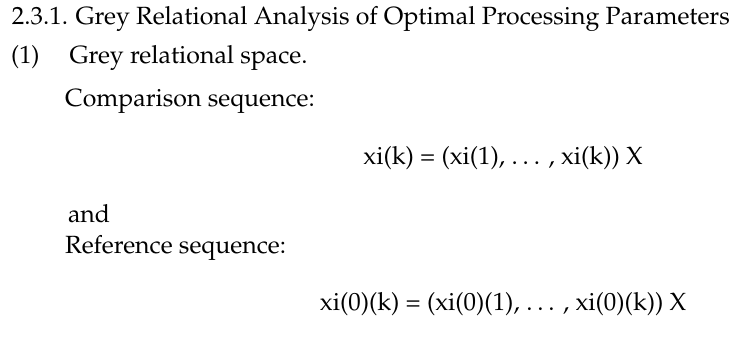
Figure 5. Meshing model by CAD (I-DEAS) and CAE (Moldflow). ( a ) Micro-sized part, sprue, runner, and gate system by CAD software drafting (I-DEAS). ( b ) Meshes of micro-sized part, sprue, runner, and gate system on Moldflow